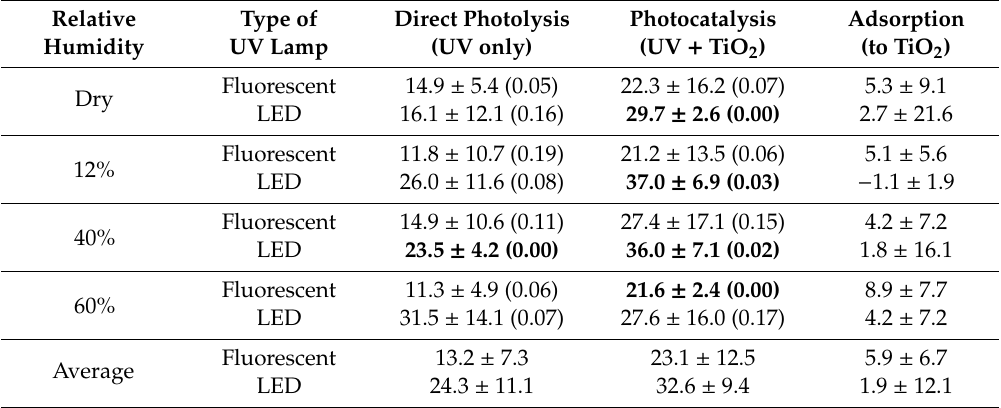
Table A11. O 3 mitigation under di ff erent light types and relative humidity at a treatment time of 40 s. Values in the table report % reduction ± standard deviation ( p -value) and are an average between treatments of NH 3 and H 2 S standard gases. Bold font signifies statistical significance.